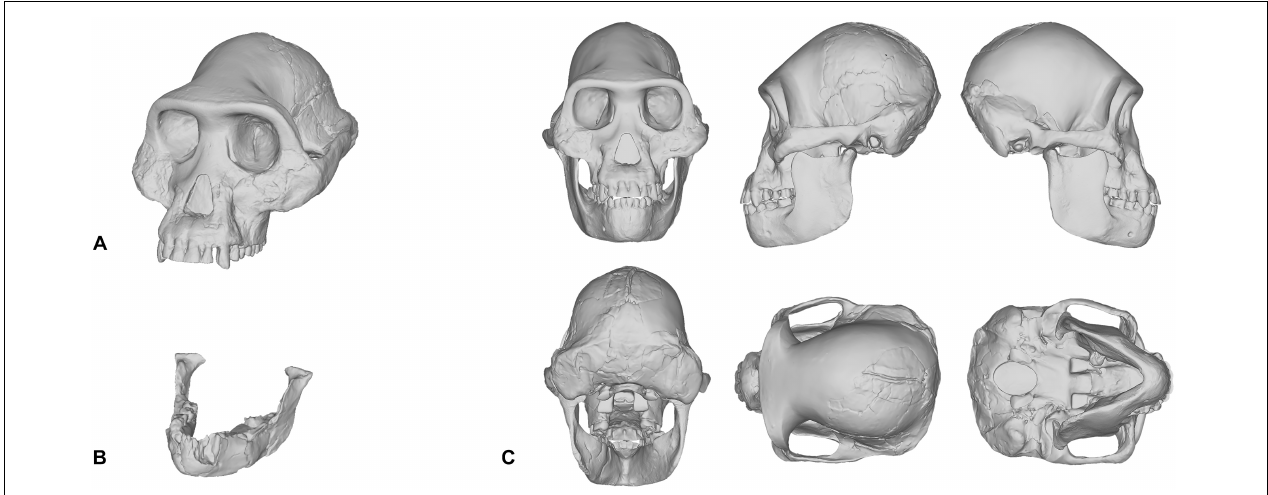
FIGURE 1 | Digital model of the Australopithecus afarensis composite male cranium reconstructed in Kimbel et al. (1984) and Kimbel and White (1988) (A) . Mandible belonging to the A.L. 288-1 (Lucy) partial skeleton (B) . Reconstruction of Lucy’s skull that was produced by scaling the male cranium to fit the A.L. 288-1 mandible (C)